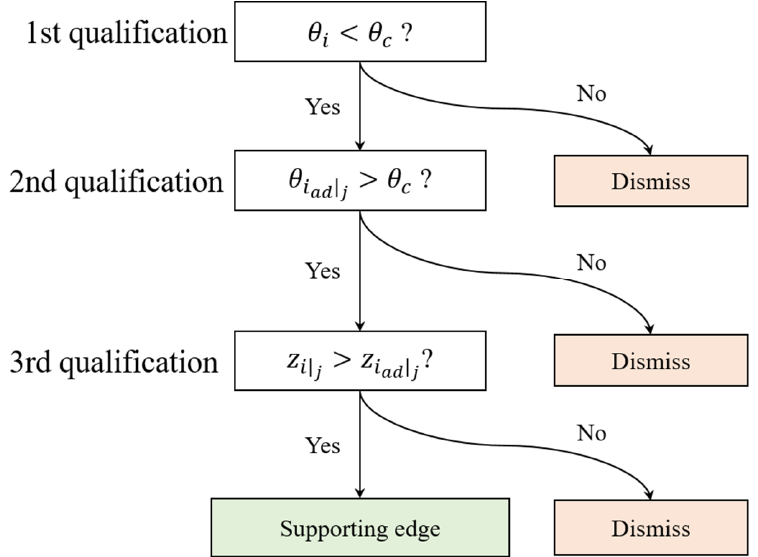
Figure 5. Decision tree for detecting supporting edges within interconnection of facets. To detect supporting edges in a pair of stable facets and a facet collapse region, the orientation angles of three adjacent facets are first addressed. Subsequently, qualified edges are determined only between a facet with a smaller orientation angle than the critical overhang angle and a facet with an orientation angle larger than the critical angle. If any of the part facets with a larger critical overhang angle are constructed earlier than the supporting facet, then the support effect will not be transferred to the unstable facet because additive manufacturing is a sequential procedure along the build direction. Therefore, the previously qualified edges are evaluated via the build sequence constriction. The build orders of a facet and its adjacent facet are classified via a comparison of their points.